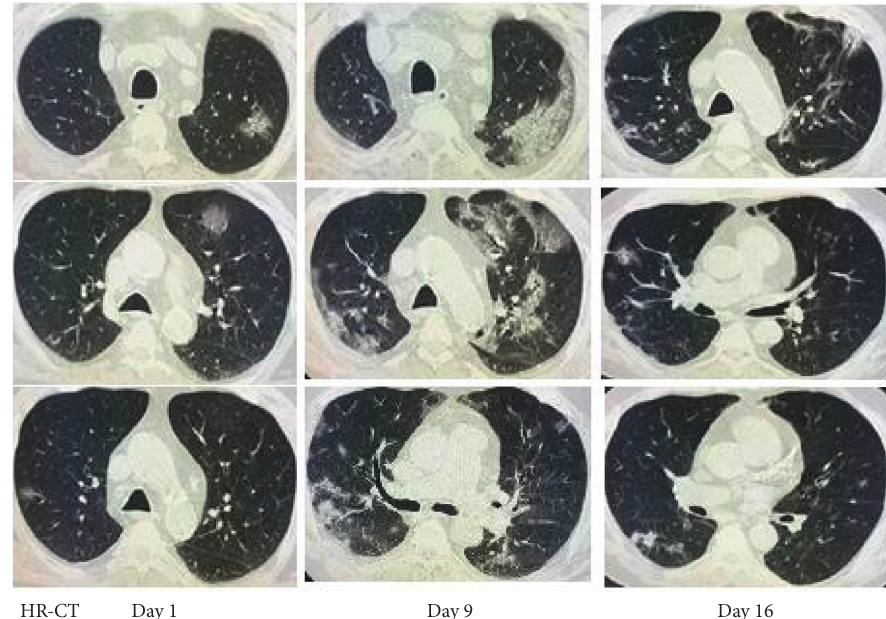
Figure 1: HR-CT findings on day 1 with few focal ground-glass opacifications (GGO), day 9 with GGO dissemination, and day 16 with substantial improvement of the lung